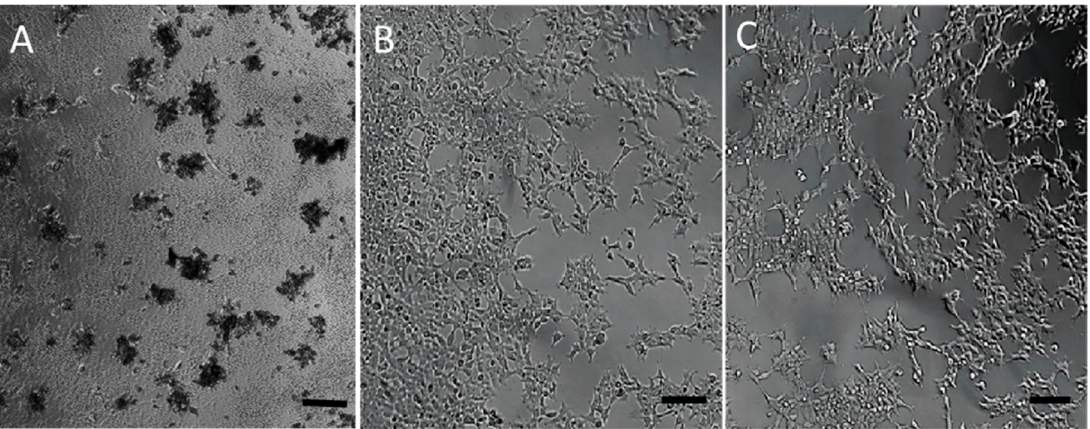
Figure 6. HEK293 cells treated with pure-surface G4 100% surface amine dendrimer ( A ), G4-90/10 ( B ), and untreated control cells ( C ). Scale bar = 100 μ m.